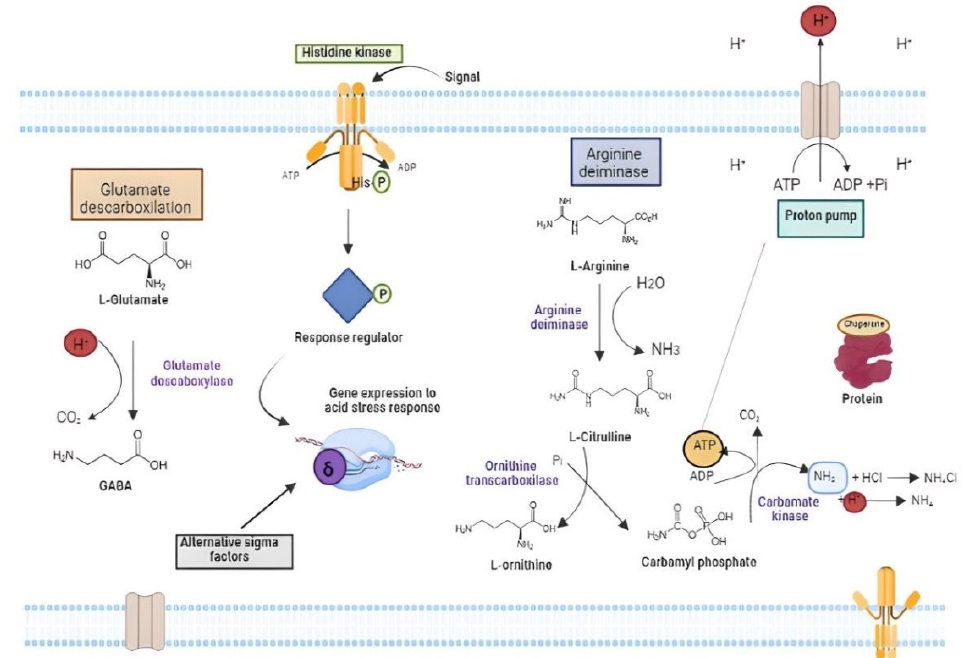
Figure 5. Overview of the main mechanisms of acid stress tolerance in lactic acid bacteria involving amino acid catabolism, expression of stress response metabolism genes by sigma alternative transcription factors activated by histidine kinase and activation of the ATP-dependent proton extrusion pump.